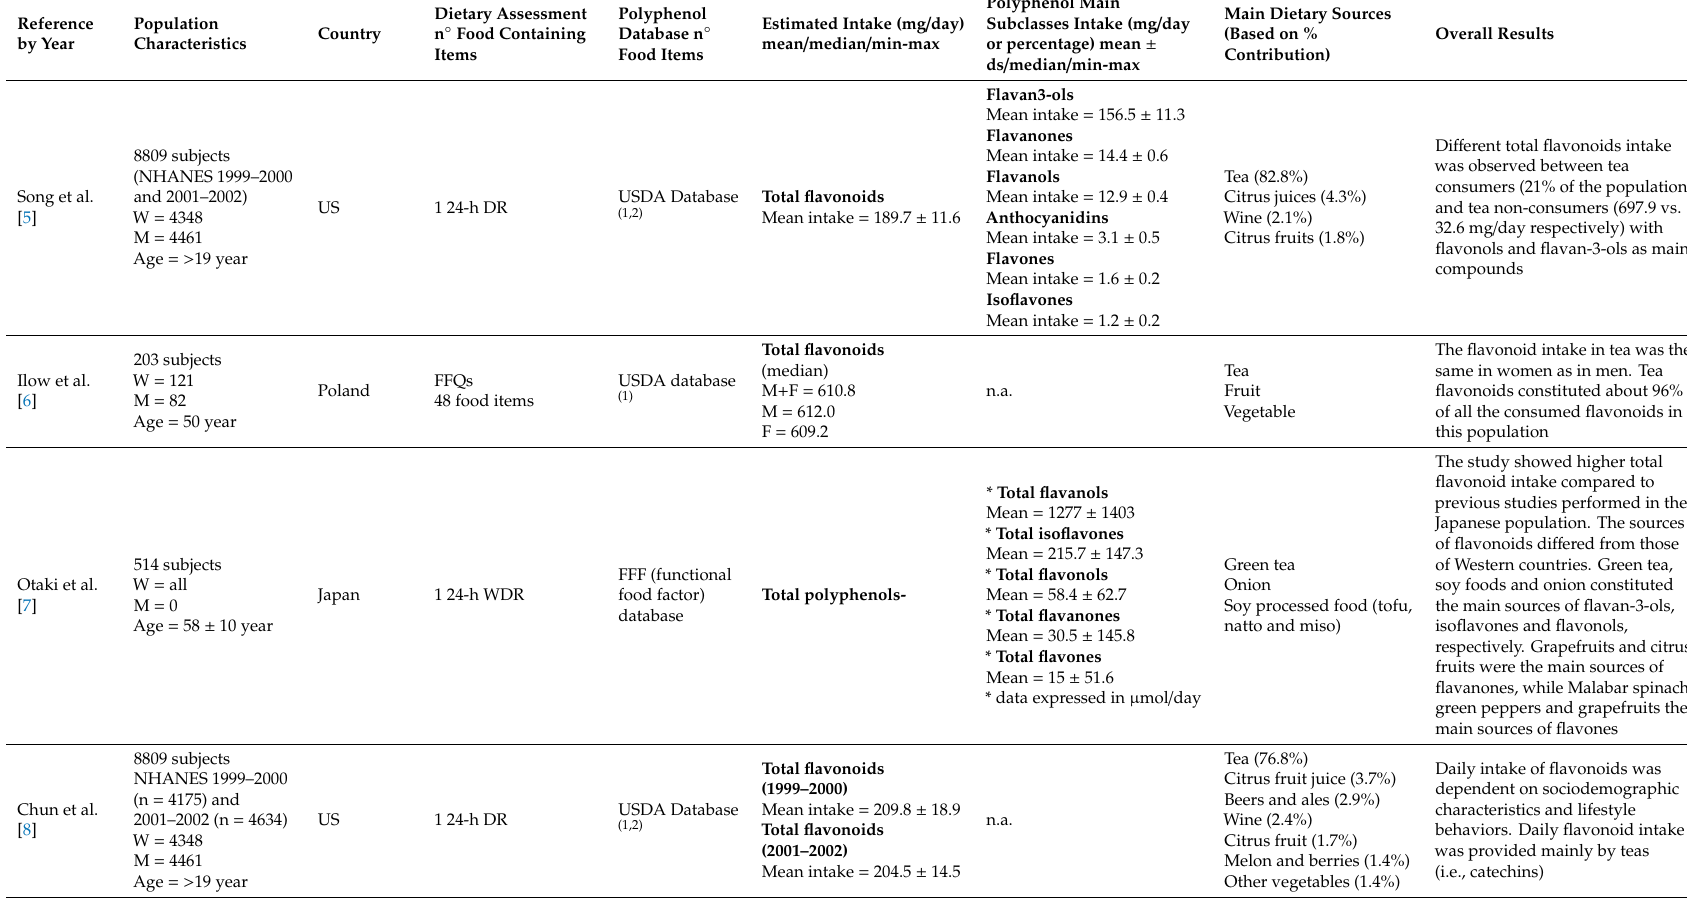
Table 1. Polyphenol intake registered in